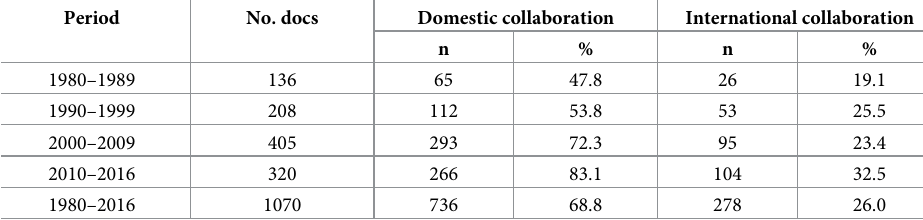
Table 5. Domestic and international collaboration on Chagas cardiomyopathy, records indexed in SCI-Expanded.